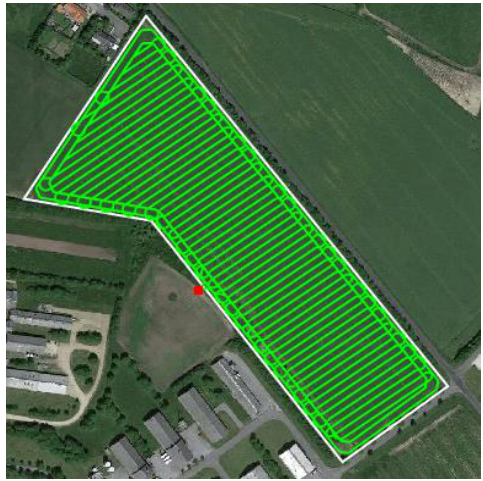
Figure 13. Demonstration of the effect of the field-work pattern on FTE. Other parameters are the same for all cases (operating width: 9 m; turning radius: 6 m; number of headlands: 2).